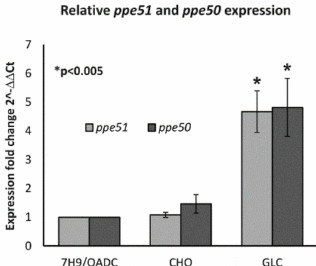
Figure 5. PPE51 is overproduced in minimal media supplemented with glycerol. Quantitative real-time PCR analysis of ppe50 / 51 gene expression in M. tuberculosis growing in three di ff erent media: rich medium (7H9 / OADC) and minimal medium supplemented with cholesterol (CHO) or glycerol (GLC). Transcript levels were normalized to sigA gene expression as the internal control. The relative fold change was determined by using the double delta method (2 − ∆∆ Ct ). Values are means ± standard errors Statistical significance: * p < 0.005 (Student’s t